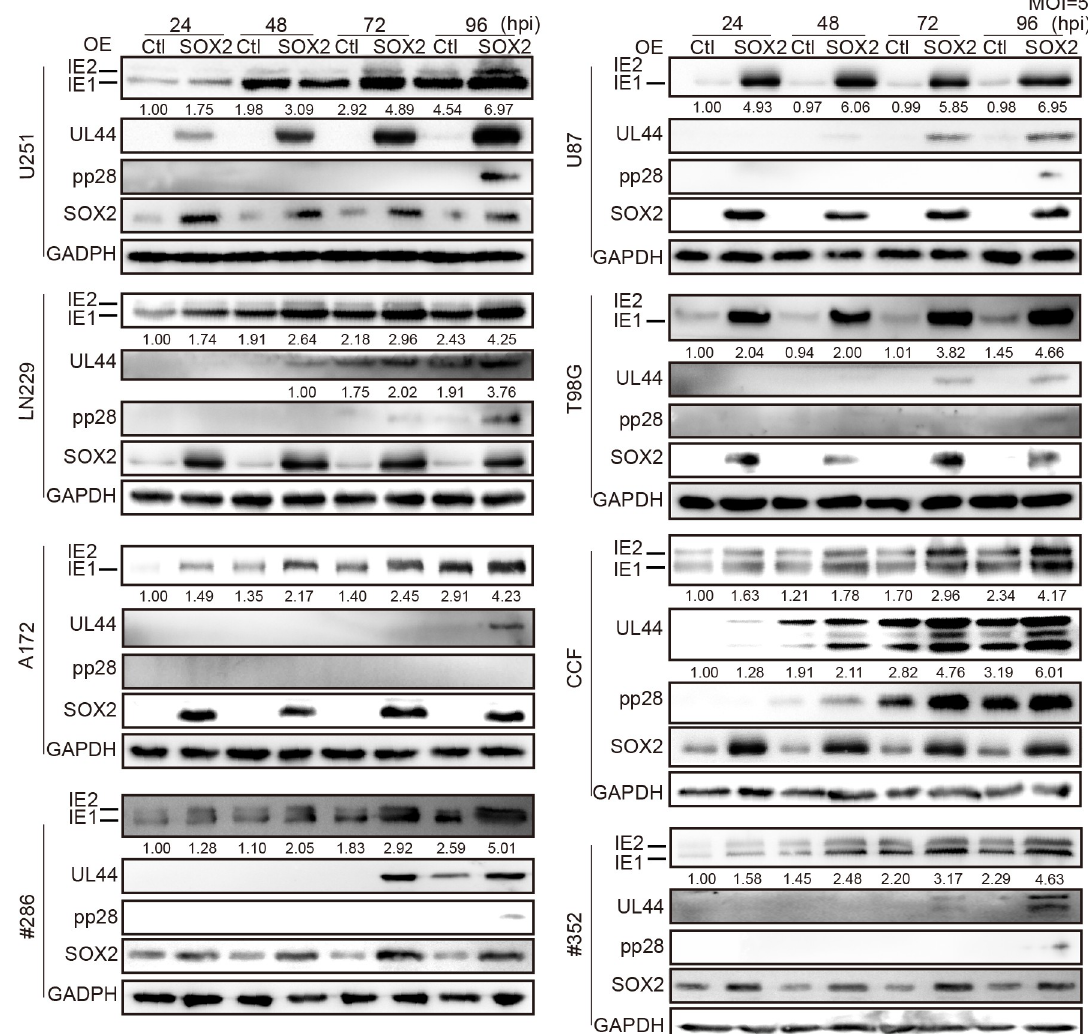
Fig 1. SOX2 promotes HCMV gene expression in glioma cells. Using lentivirus transduction, SOX2 overexpressing (OE) and control (Ctl) cells were made from glioma cell lines of U251, U87, LN229, T98G, A172, and CCF and primary glioma stem cells (GSCs) from two glioblastoma (GBM) cases, #286 and #352. The cells were infected with the HCMV Towne strain at an MOI of 5 and collected at the indicated times for immunoblotting (IB) analysis. Protein expression of SOX2 and HCMV protein IE1/2, UL44 (early protein), and pp28 (late protein) in SOX2-OE and Ctl cells are shown. GAPDH served as an internal control for protein quantification normalization. Relative levels of the indicated proteins are listed below the blots. Data are representative of three independent